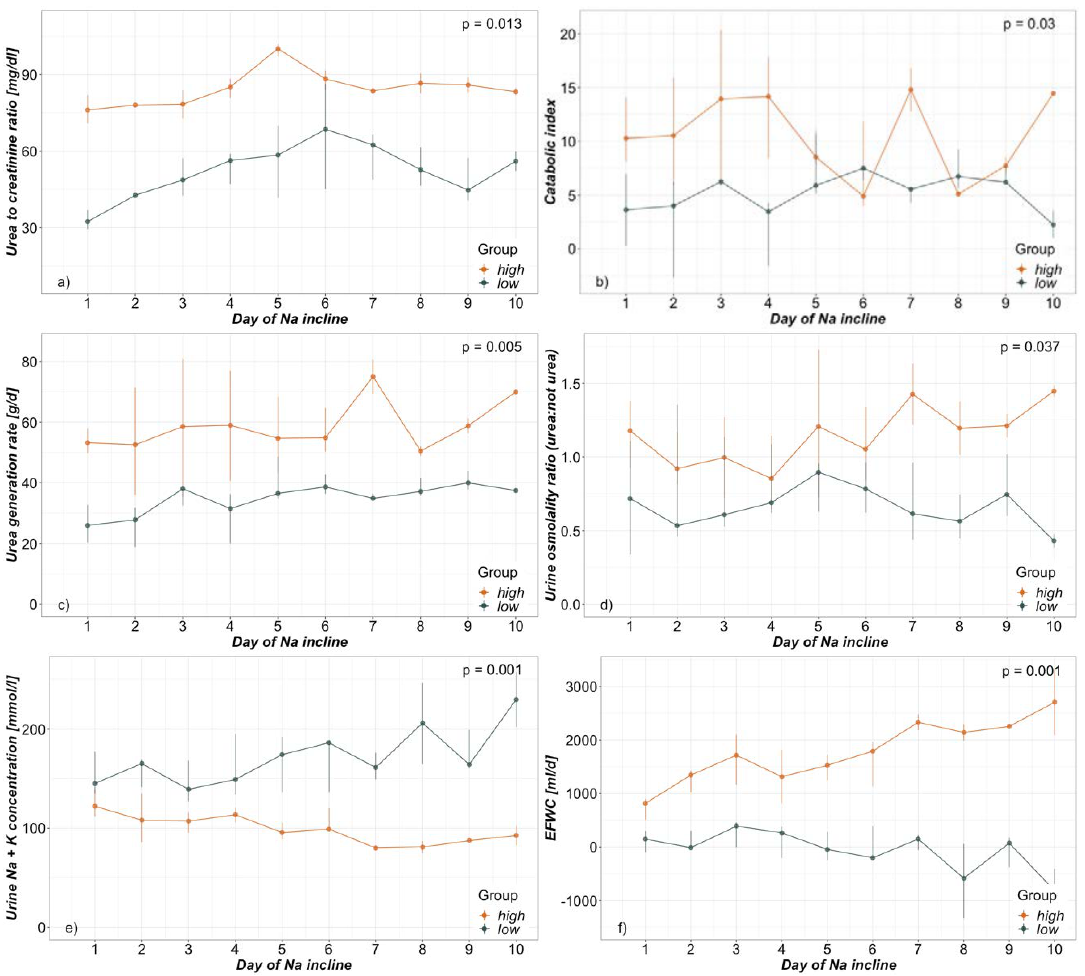
Figure 1. Day of NaS incline dependent group analysis presented as daily median and interquartile range of ( a ) Urea:Creatinine ratio ( b ) Catabolic index ( c ) Urea generation rate ( d ) Urine osmolality ratio (urea:not urea) ( e ) Sum of urine sodium and potassium concentrations and ( f ) electrolyte-free water clearance (EFWC).